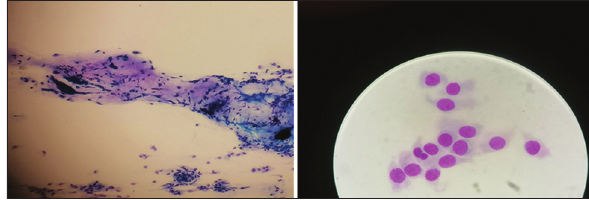
Figure-6: Soft brush cytology sample-to the left 20× magnification, to the right 100× magnification.